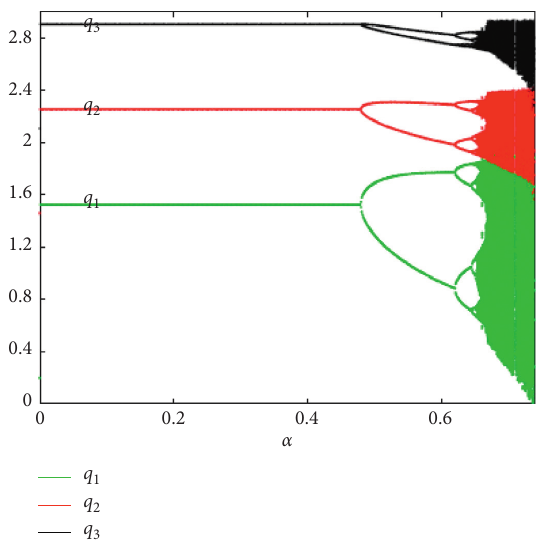
Figure 5: Bifurcation diagram of the nonlinear dynamic system (12) with α